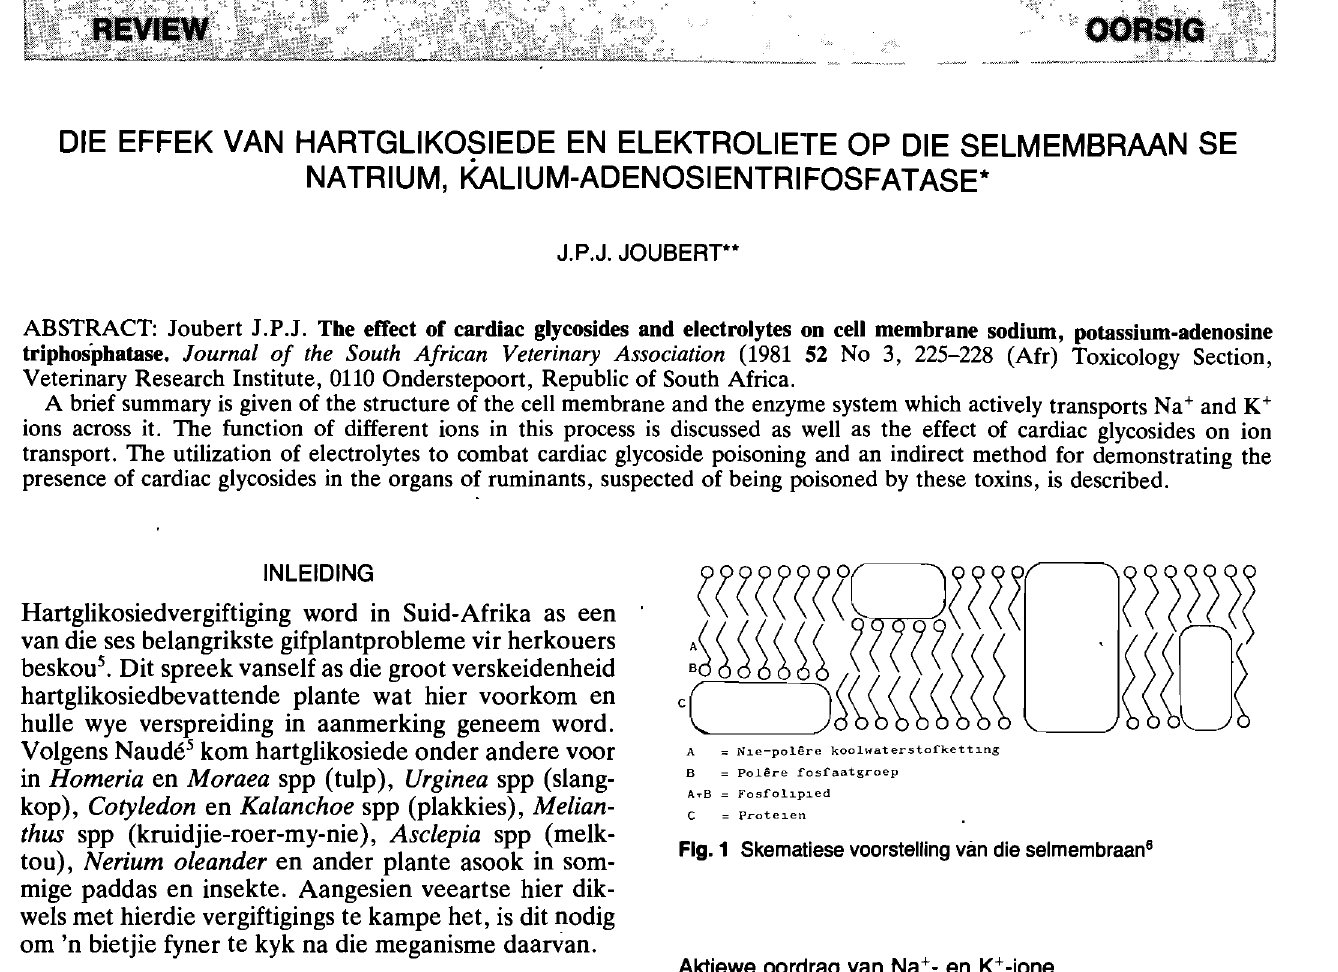
Aktiewe oordrag van Na+ - en K+